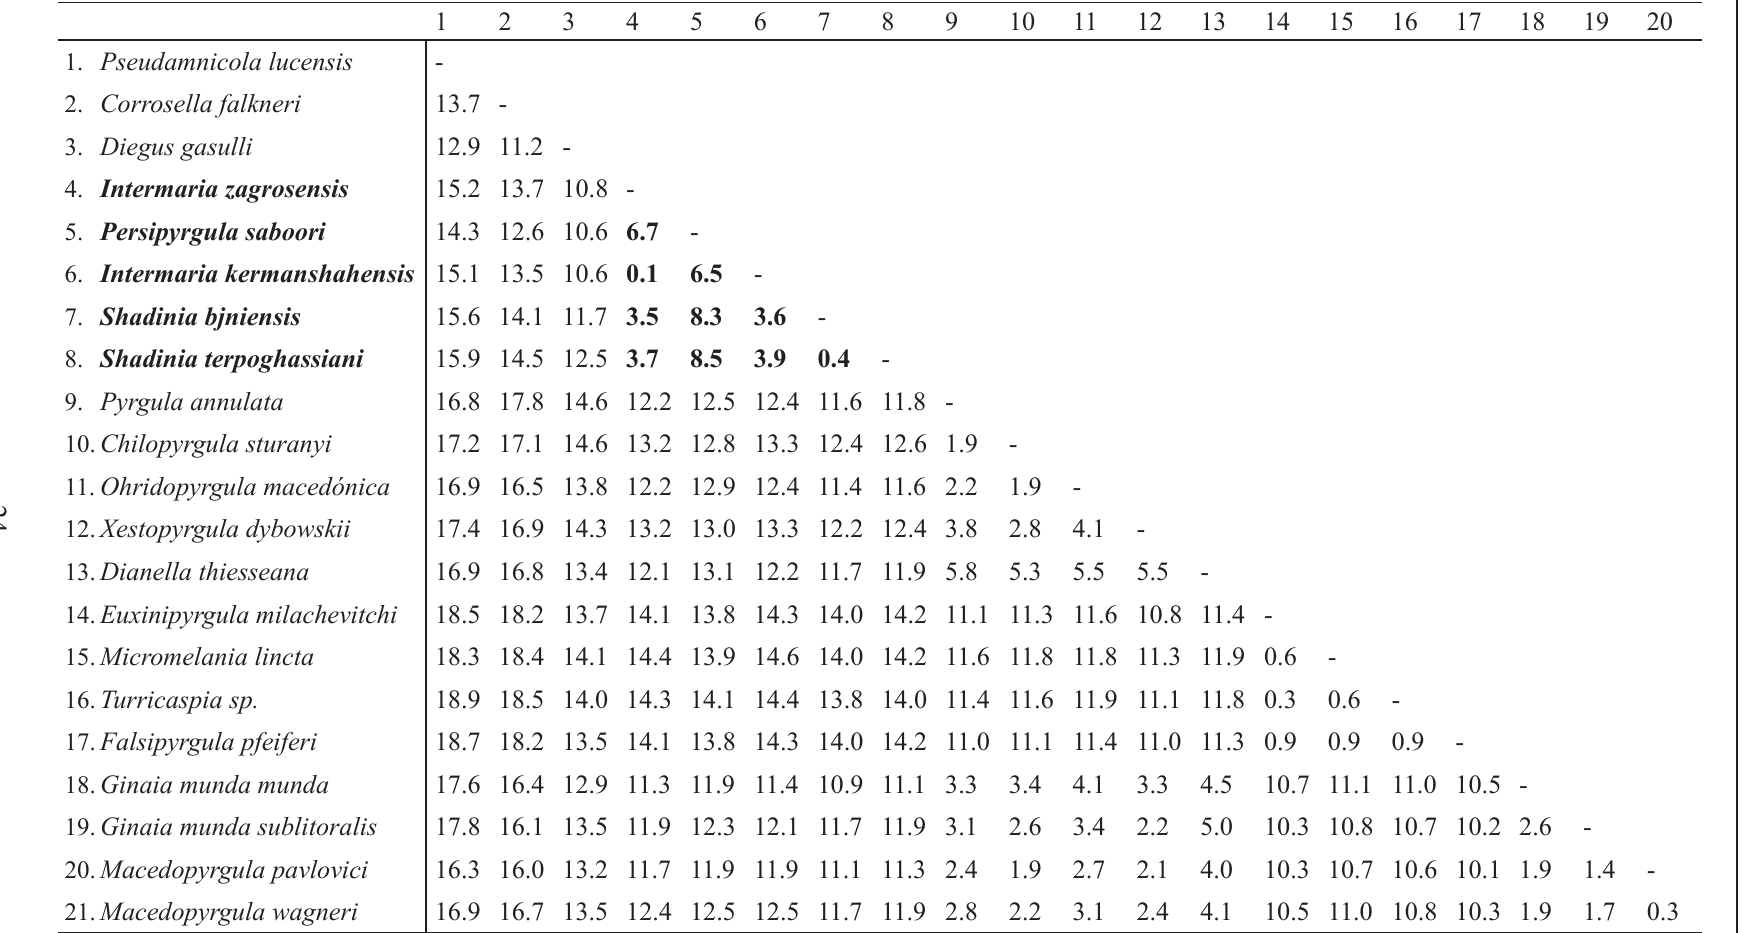
Table 4. Uncorrected COI p-distances between species of the subfamilies Pyrgulinae and